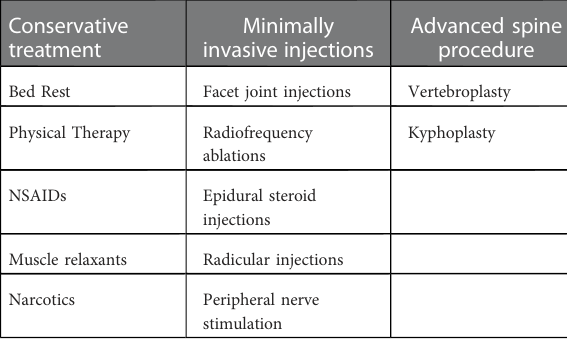
TABLE 1 Current treatment options for pain due to vertebral compression fracture. Conservative Minimally treatment invasive